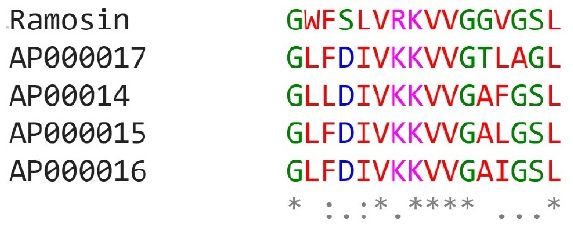
Figure 8. Alignment of the Ramosin peptide sequence from Bolitoglossa ramosi and the Aurein sequences reported in APD3: AP00017 (Aurein 2.4), AP00014 (Aurein 2.1), AP00016 (Aurein 2.3), AP00015 (Aurein 2.2) [49]. The asterisk (*) indicates positions which have a single, fully conserved residue. The colon (:) indicates conservation between groups of strongly similar properties and a period (.) indicates conservation between groups of weakly similar properties. Table 4. Physicochemical properties of Ramosin peptide from B. ramosi